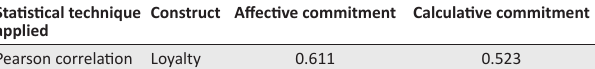
TABLE 5: Correlation and collinearity